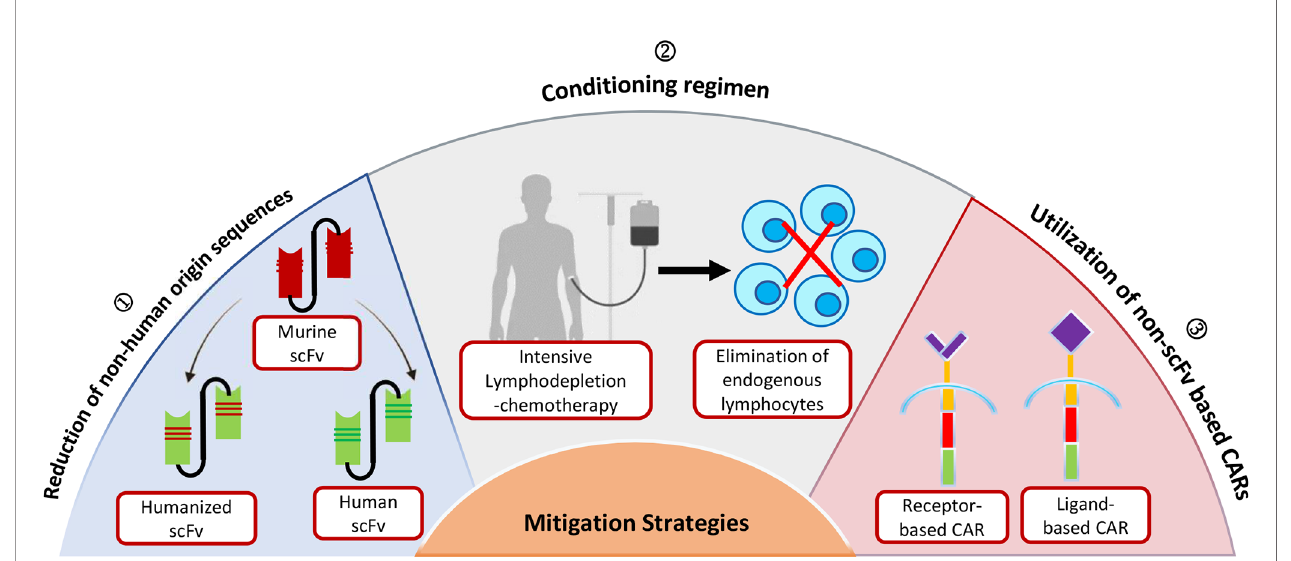
FIGURE 2 | Strategies for limiting the Immunogenicity of Chimeric Antigen Receptor (CAR) T